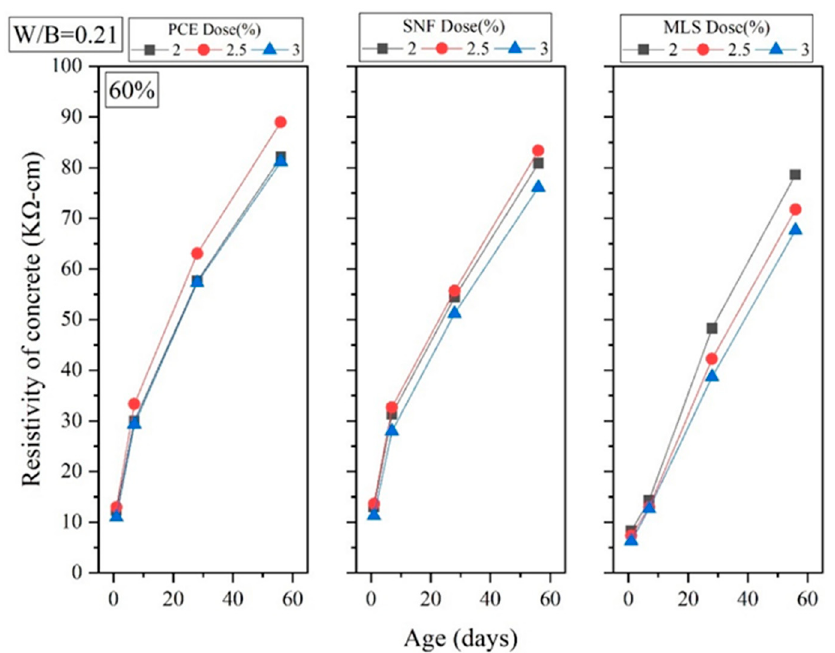
Figure 23. Four-terminal resistance of green and ecofriendly grouting material with sand content of 70%.